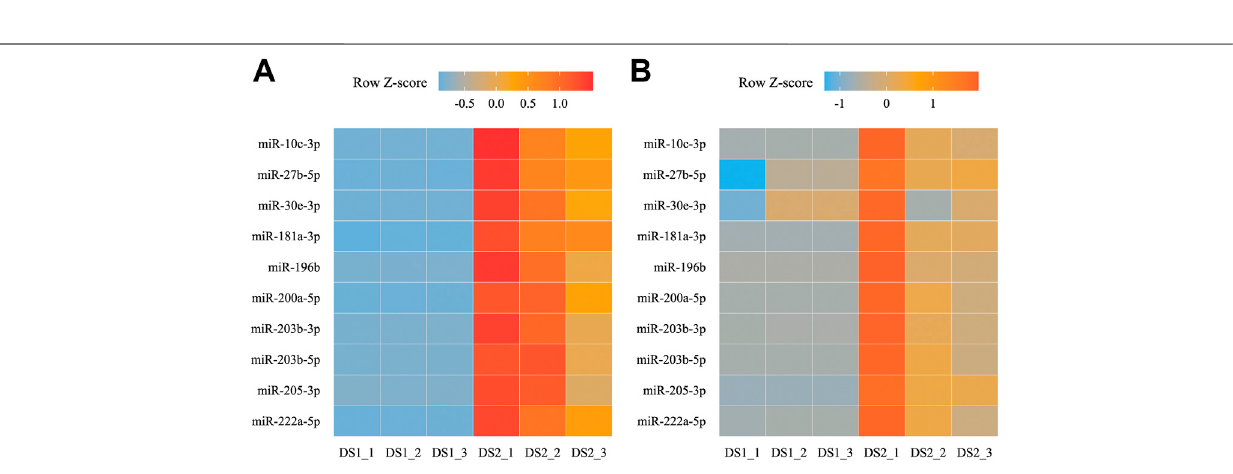
FIGURE 7 | Heat maps for transcripts per million (TPM) (A) and relative expression (B) of ten differentially expressed miRNAs (DEMs) between two early developmental